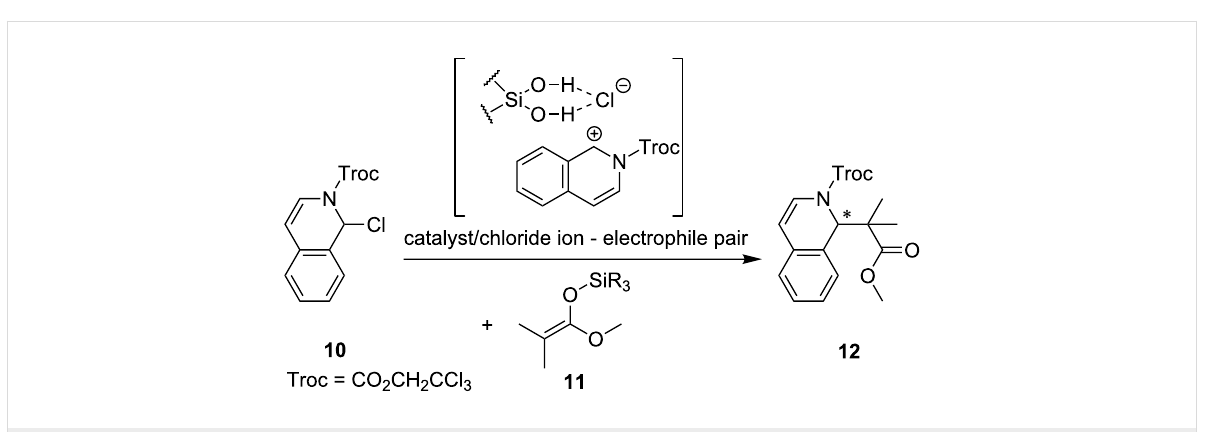
Scheme 1: Hydrogen-bond-catalyzed N -acyl Mannich reaction of in situ-generated isoquinolin derivative 10 with different silyl ketene acetals 11 yielding C–C coupling product 12